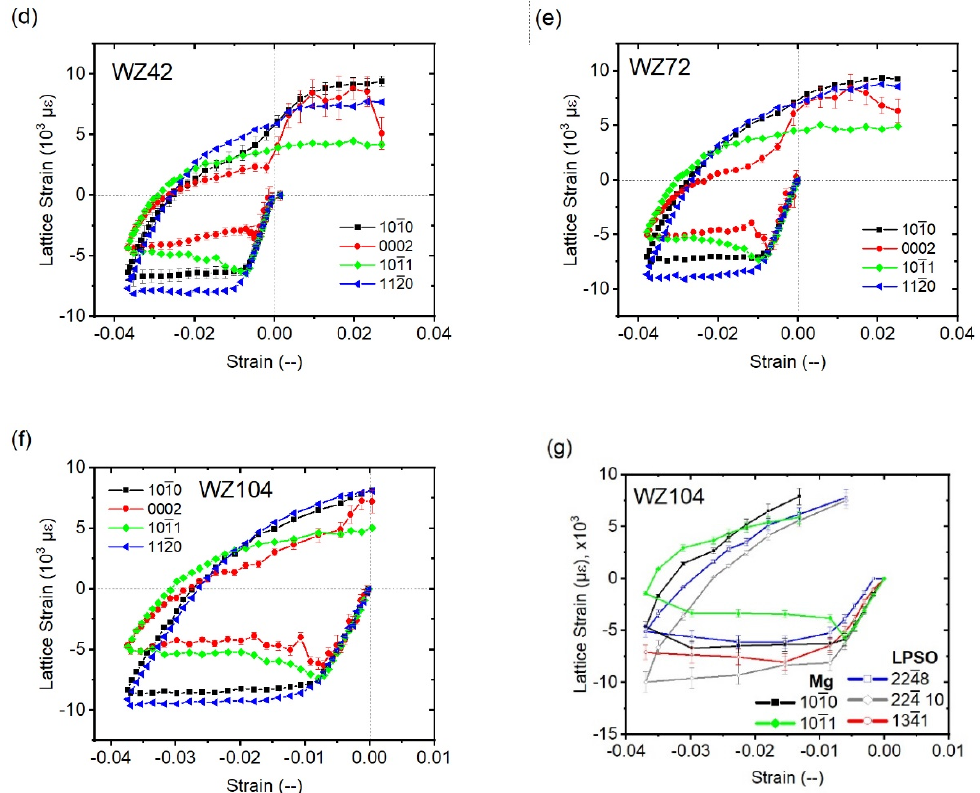
Figure 6. The elastic lattice strains plotted for axial detection as a function of applied stress and strain for the ( a , d ) WZ42, ( b , e ) WZ72, and ( c , f , g ) WZ104 alloys. The lattice strains for the long-period stacking ordered (LPSO) peaks were evaluated from the discontinuous measurement data.